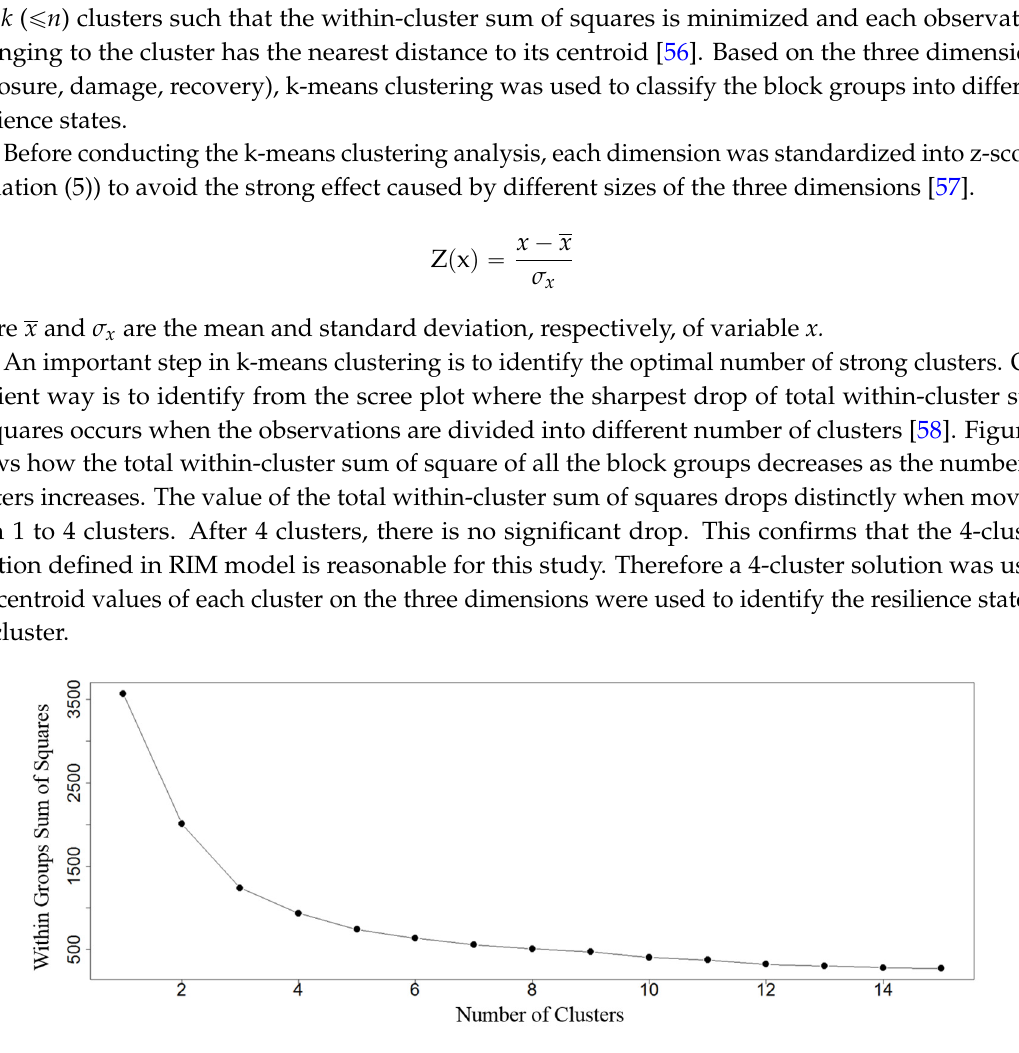
Figure 3. Plot of total within-cluster sum of squares against number of clusters.